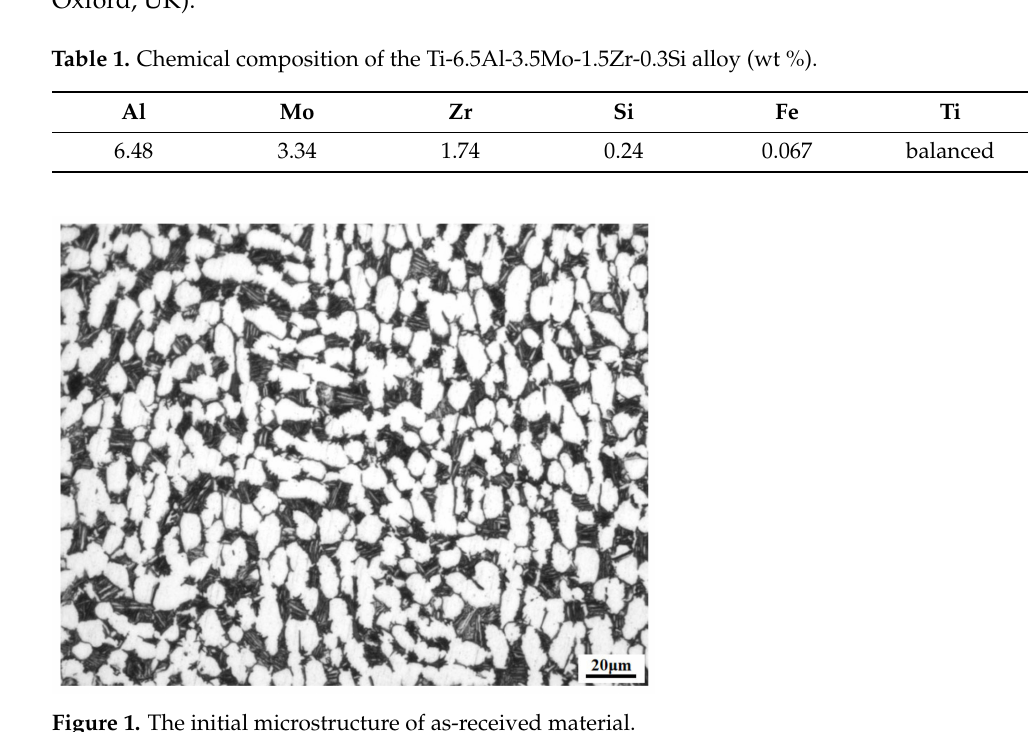
Figure 1. The initial microstructure of as-received